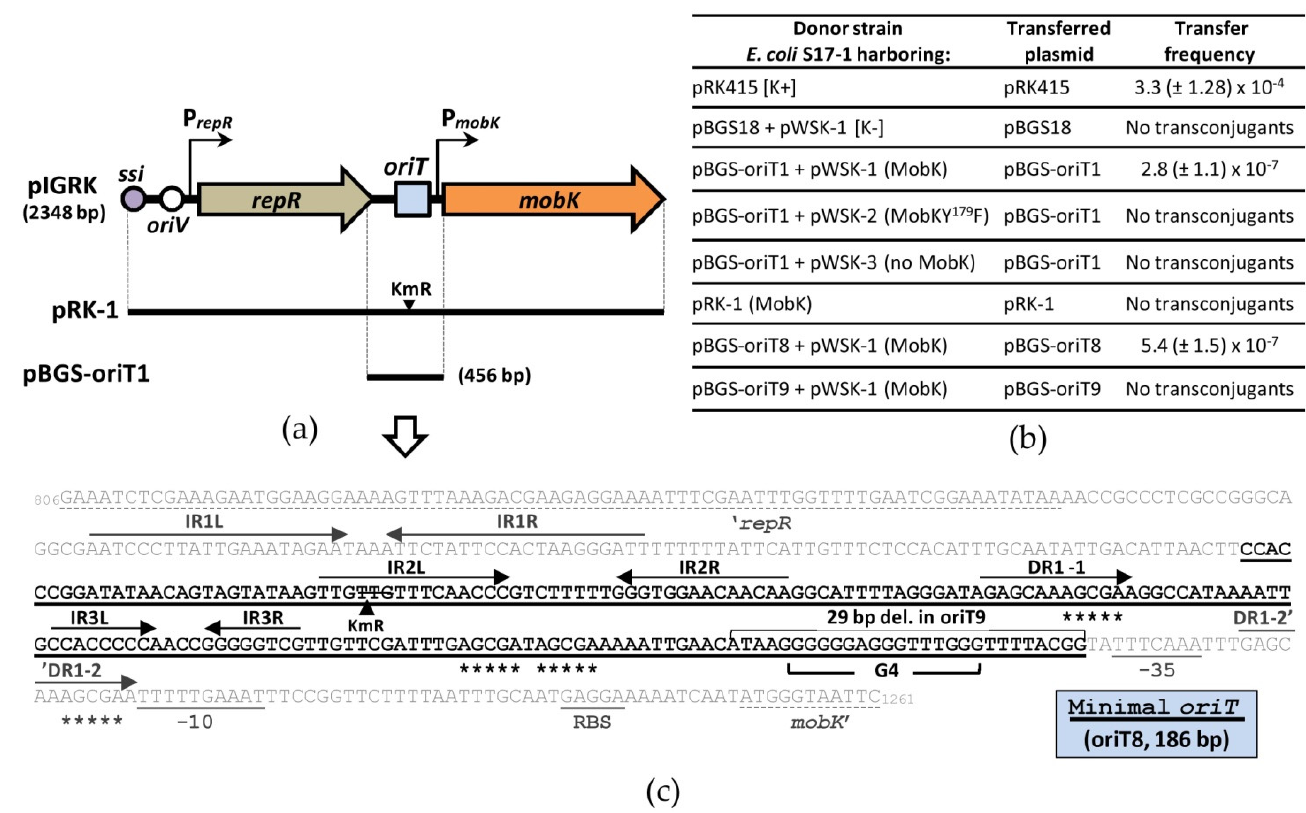
Figure 2. Functional analysis of the components of the pIGRK MOB module. ( a ) Genetic organization of pIGRK. Conjugal transfer origin ( oriT ) and relaxase gene ( mobK ), as well as vegetative replication origin ( oriV ), replication initiator gene ( repR ) and single-strand initiation sequence ( ssi ) are indicated [32]. Promoters of mobK (P mobK ) and repR (P repR ) genes are marked as black arrows [32]. Black lines represent the DNA fragment of pIGRK and its mutated version with the insertion of a kanamycin resistance cassette (KmR). ( b ) Mutational analysis of pIGRK mobilization system. Transfer frequency is presented as the number of transconjugants per donor cell. As a positive control pRK415 plasmid, containing RK2 oriT sequence was used. ( c ) Nucleotide sequence of oriT1 region cloned in pBGS-oriT1. Minimal oriT (oriT8 fragment cloned in pBGS-oriT8) is marked in bold black font with solid line underlined. Sequences of the C -terminal part of repR gene and the N -terminal part of mobK gene are underlined with dotted lines. Regulatory sequences of mobK gene: in silico predicted promoter region (using BPROM [33]) as well as RBS, ribosome binding site are indicated by a wavy line. DNA bases of four 5 ′ -AGCGA-3 ′ motifs are indicated by asterisks. IR, inverted repeats; DR, direct repeats; DNA bases replaced by kanamycin resistance cassette (KmR) insertion in pRK-1. Putative G—quadruplex DNA (G4), predicted using G4IPDB [34] as well as bases deleted in pBGS-oriT9 are presented.